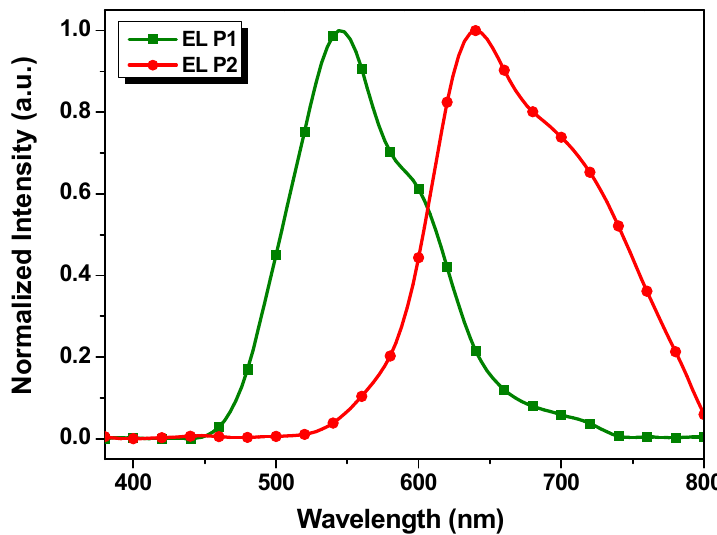
Figure 5. EL spectra P1 and P2 -based devices.